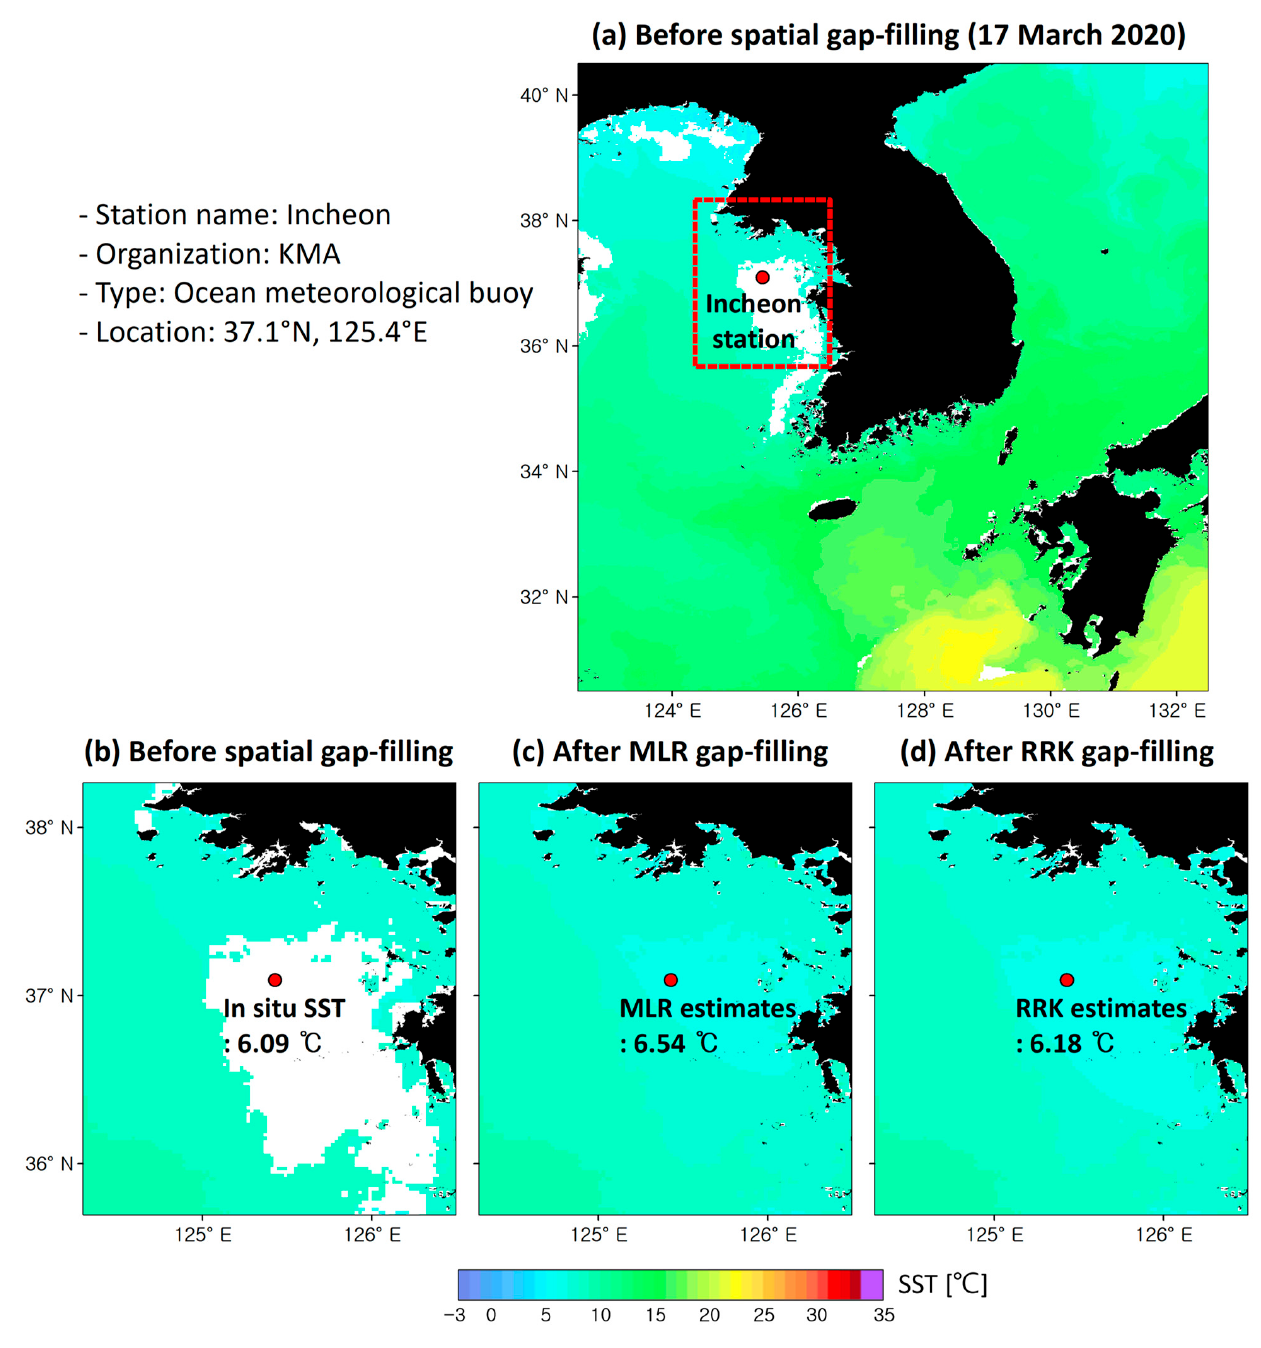
Figure 17. GK2A SST maps before and after the MLR and RRK gap-filling around the Incheon station on 17 March 2020. ( a ) The location of the Incheon station in the study area. ( b ) denote images before spatial gap-filling. ( c ) gap-free SST after MLR, and ( d ) gap-free SST after RRK.